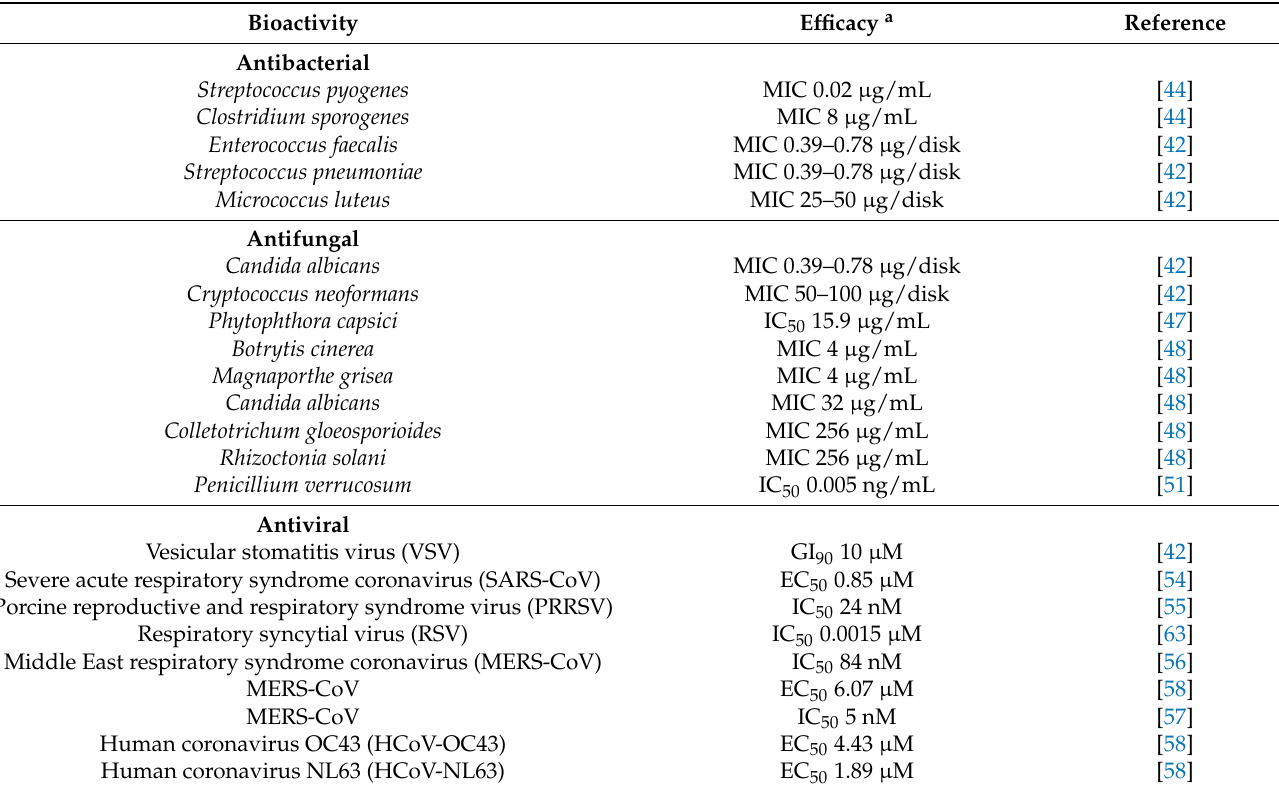
Table 1. Summary of valinomycin